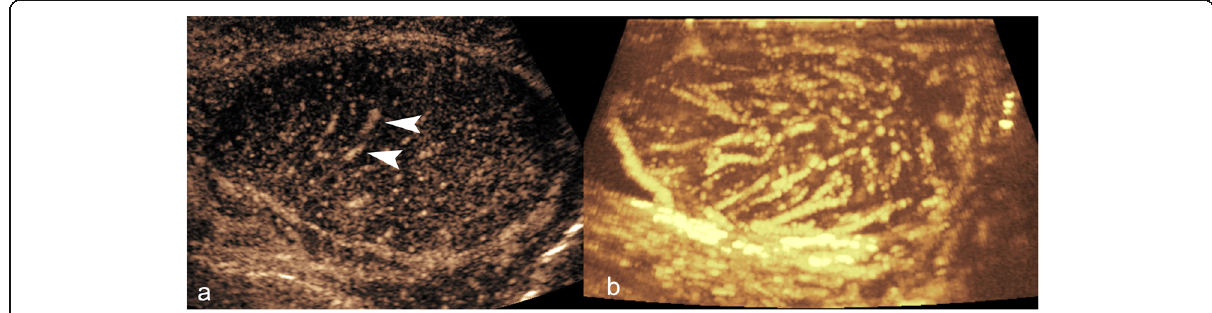
Fig. 1 Normal CEUS appearances of testicular parenchyma. Static image ( a ) showing the normal linear/striated mediastinal vessels outlined by microbubbles (arrowheads). Temporal prolonged contrast acquisition image (MIP) ( b ) showing the vascular architecture of normal testicular